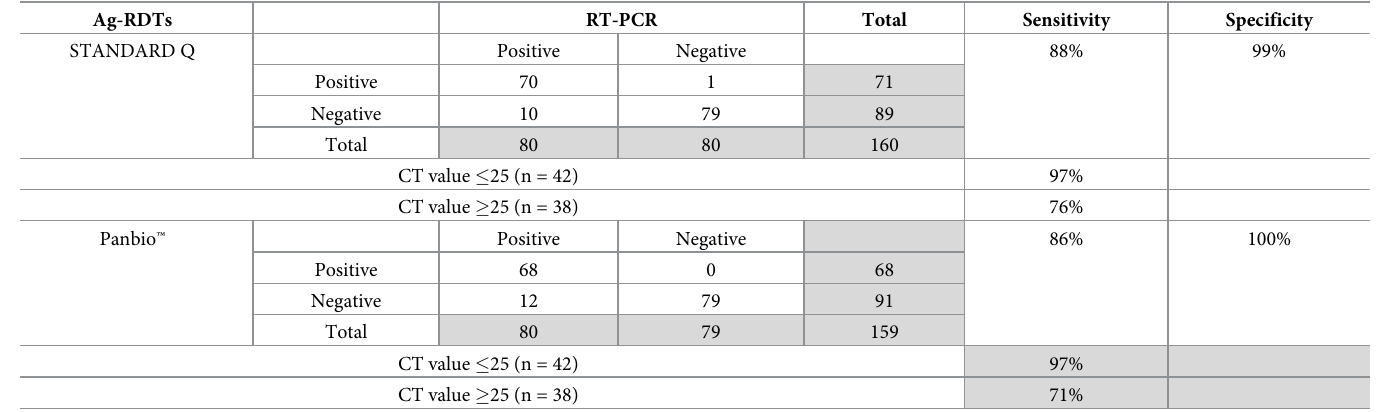
Table 2. Determination of the Ag-RDTs sensitivity and specificity.